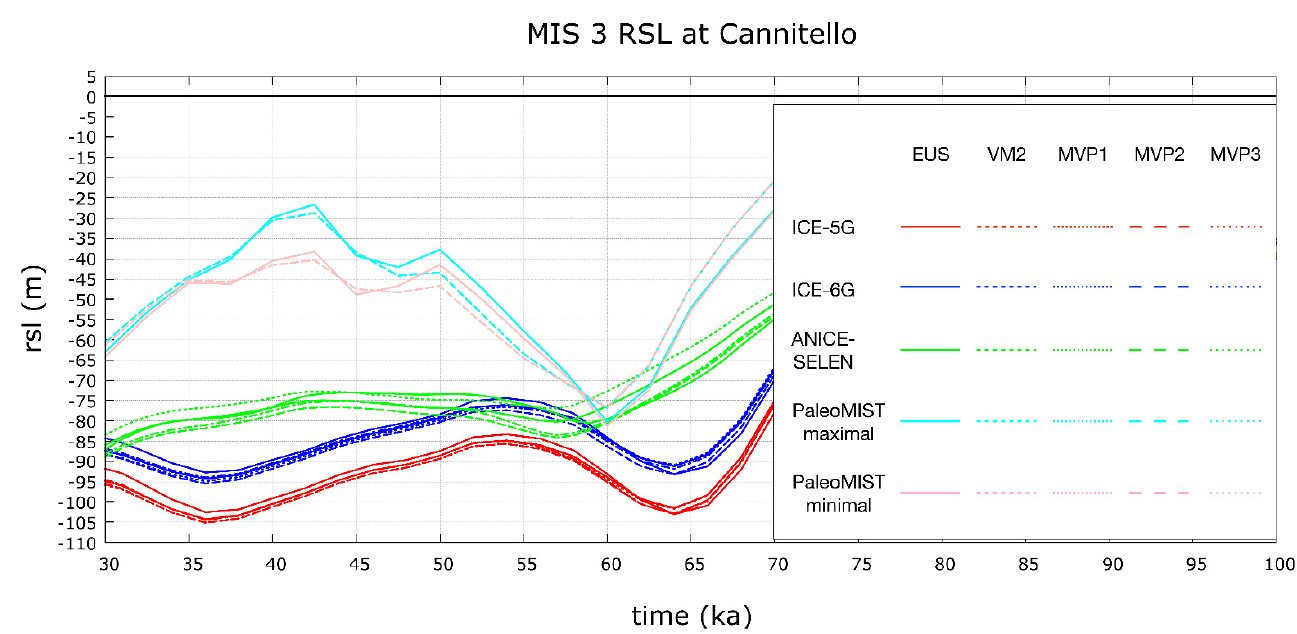
Figure 7. Predicted RSL curves for four ice sheet models: ICE-5G (red), ICE-6G (blue), ANICE-SELEN (cyan), and PaleoMIST 1.0 maximal and minimal (cyan and pink, respectively). The solid curves represent the eustatic. The dashed and dashed-dotted curves represent the GIA-modulated RSl predictions.